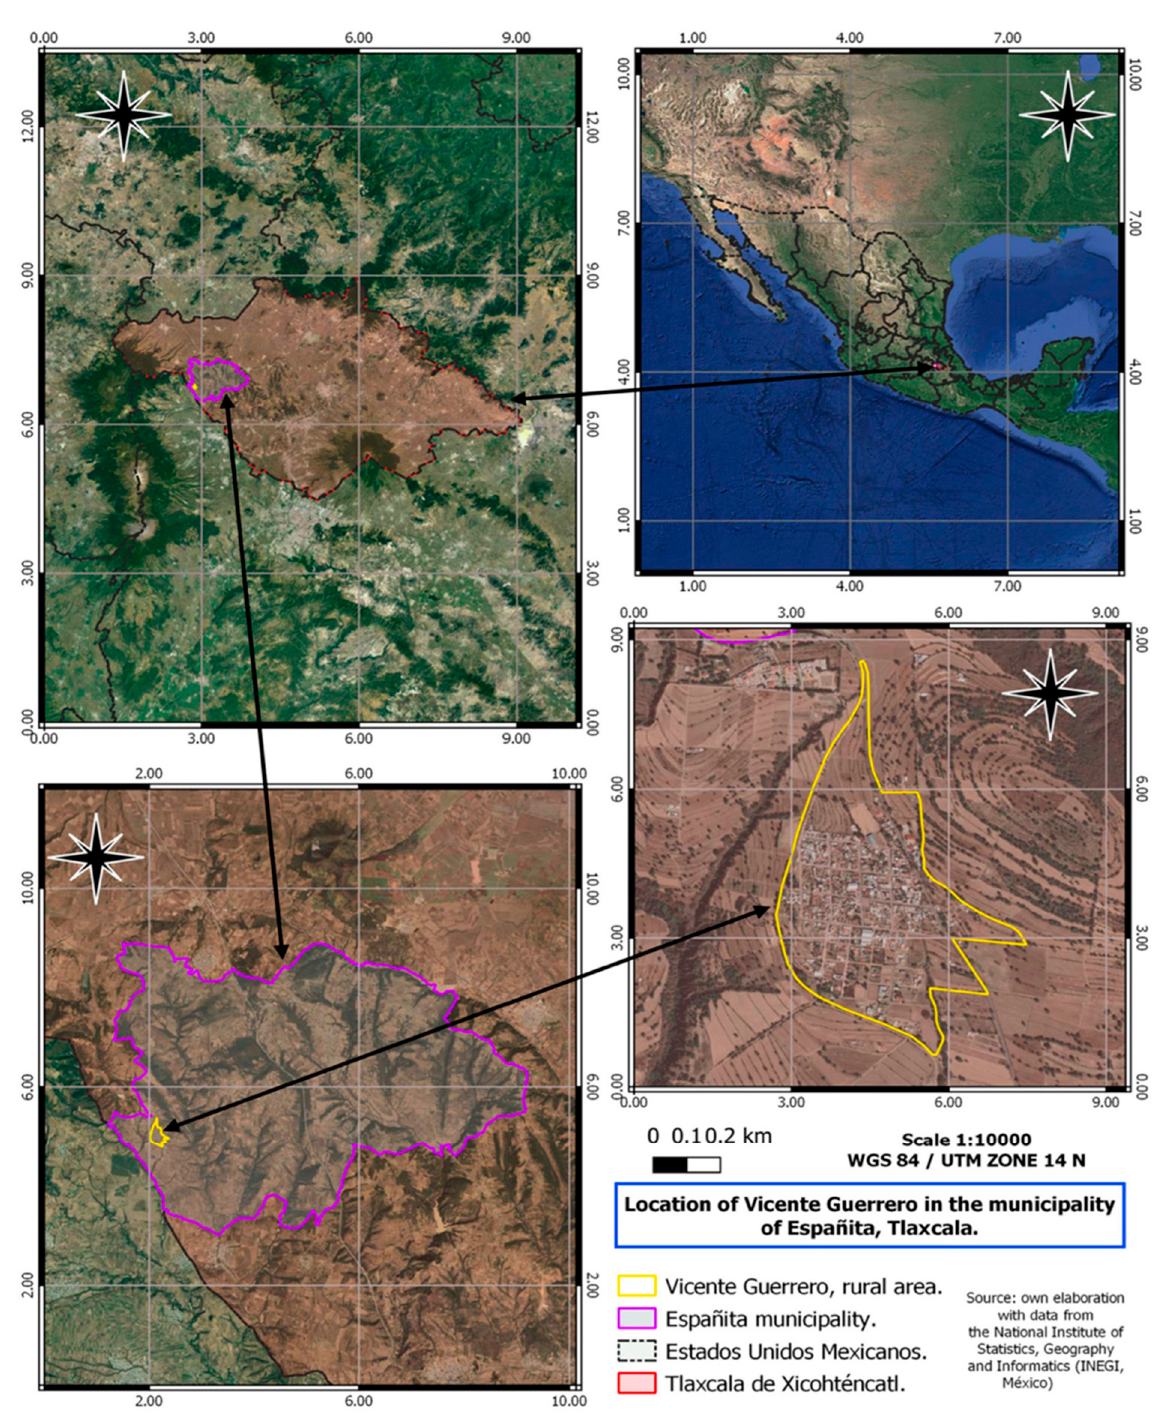
Figure 1. Overview of the geographical location of the study site (locality of Vicente Guerrero, Españita-Tlaxcala, Mexico) [21].